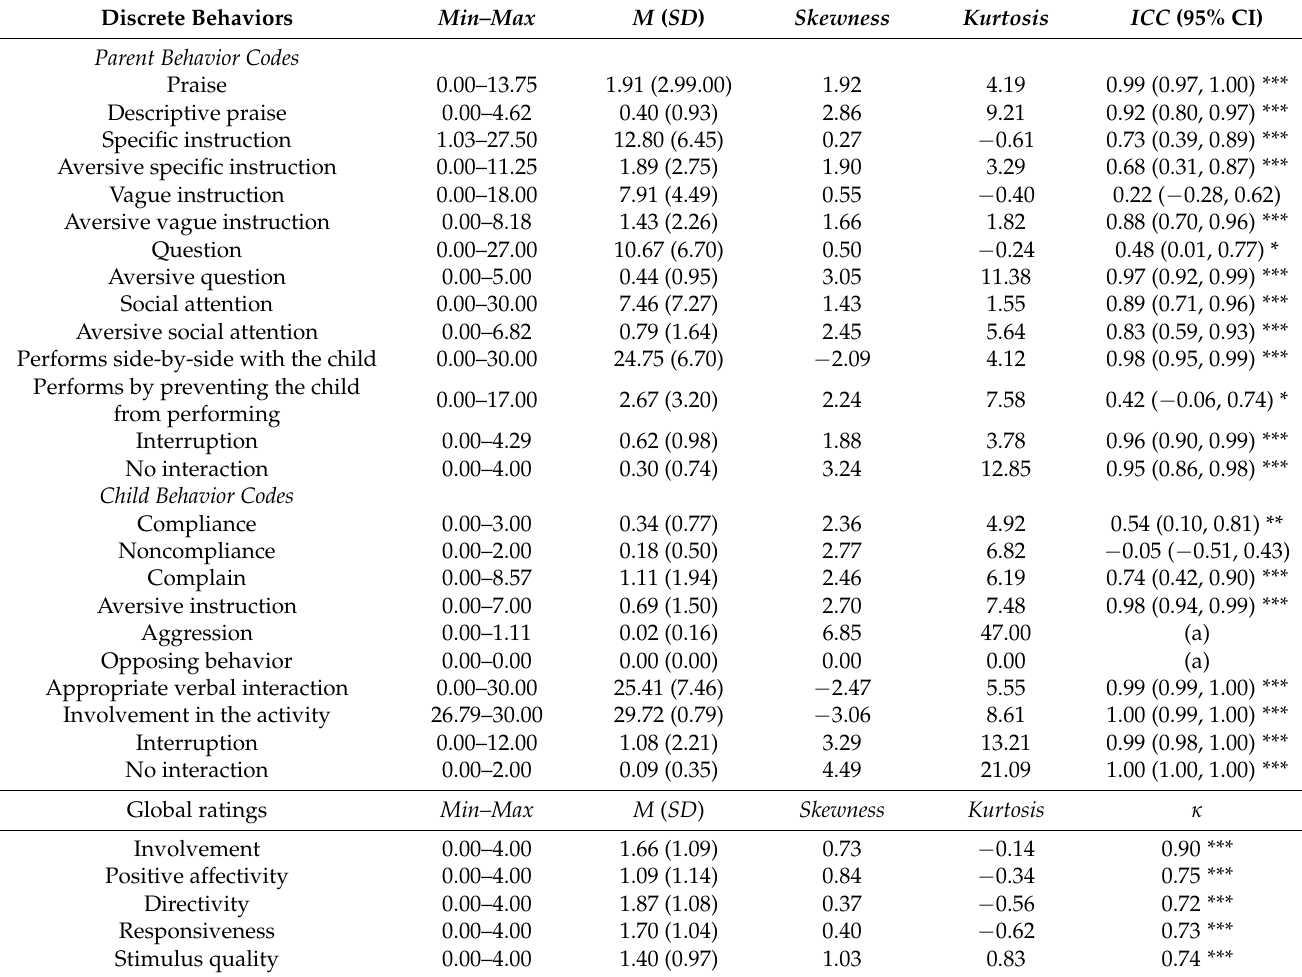
Table 3. Descriptive statistics and inter-rater agreement (ICC and κ ) of the discrete behaviors and global